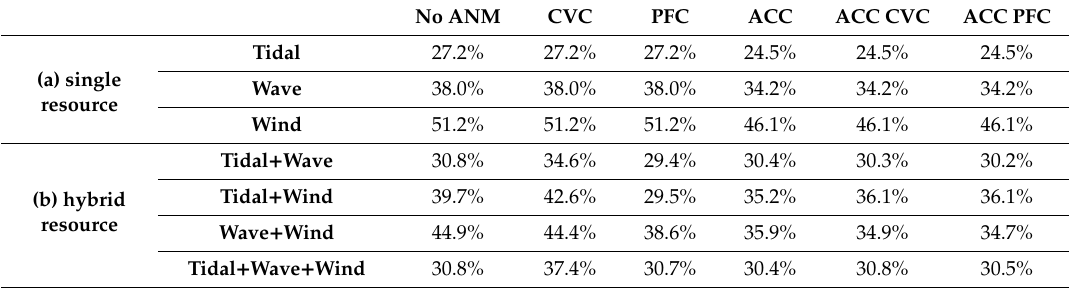
Table 7. Effective capacity factor (delivered energy after curtailment) for a range of control